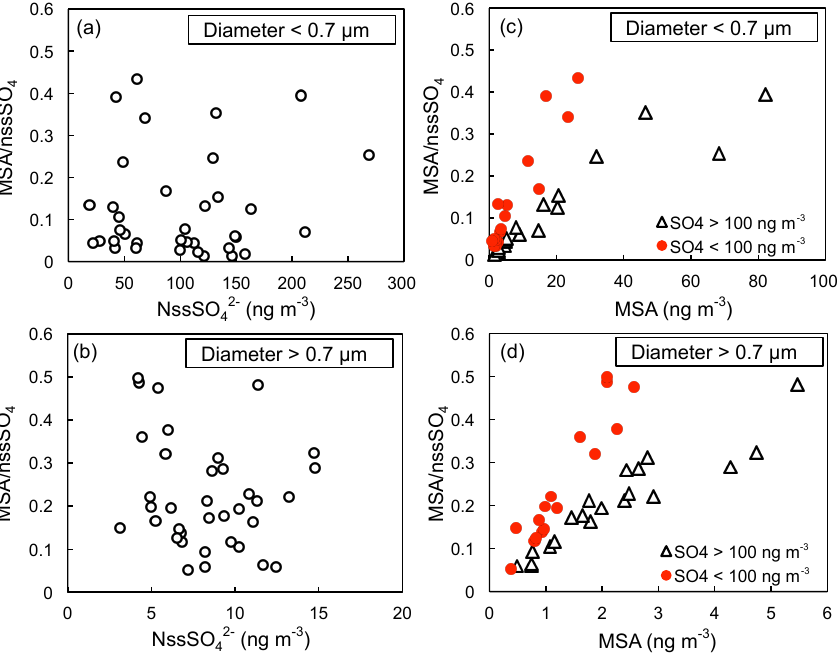
Figure 7. Relationship between the MSA / nssSO 4 ratio and the nssSO 4 level in small (a) and large (b) particles collected on the 12-stage impactor in summer (from November to March). Panels (c) and (d) are the same for the relationship between the MSA / nssSO 4 ratio and the MSA level, distinguishing samples containing more (open triangles) or less (red points) than 100ngm − 3 of nssSO 4